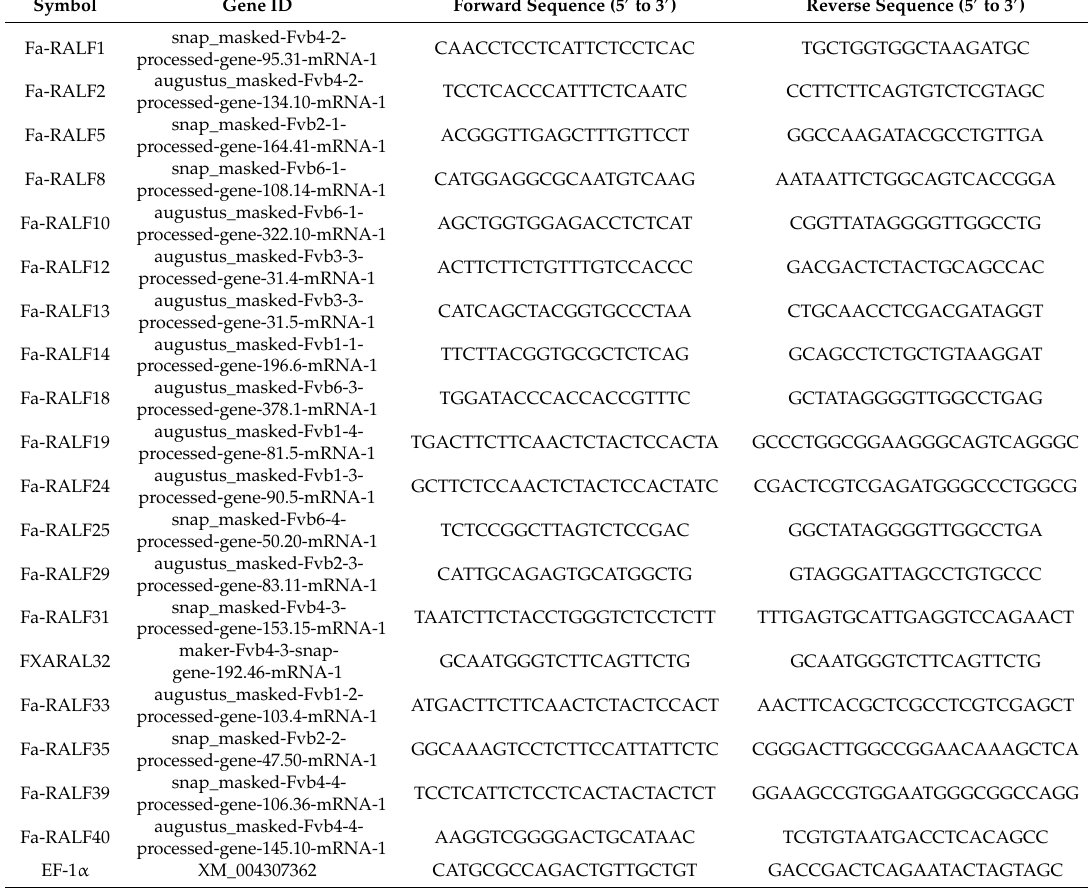
Table 1. Primers used to perform quantitative real-time PCR (RT-qPCR) for RALF- like genes. Symbol Gene ID Forward Sequence (5 (cid:48) to 3 (cid:48)